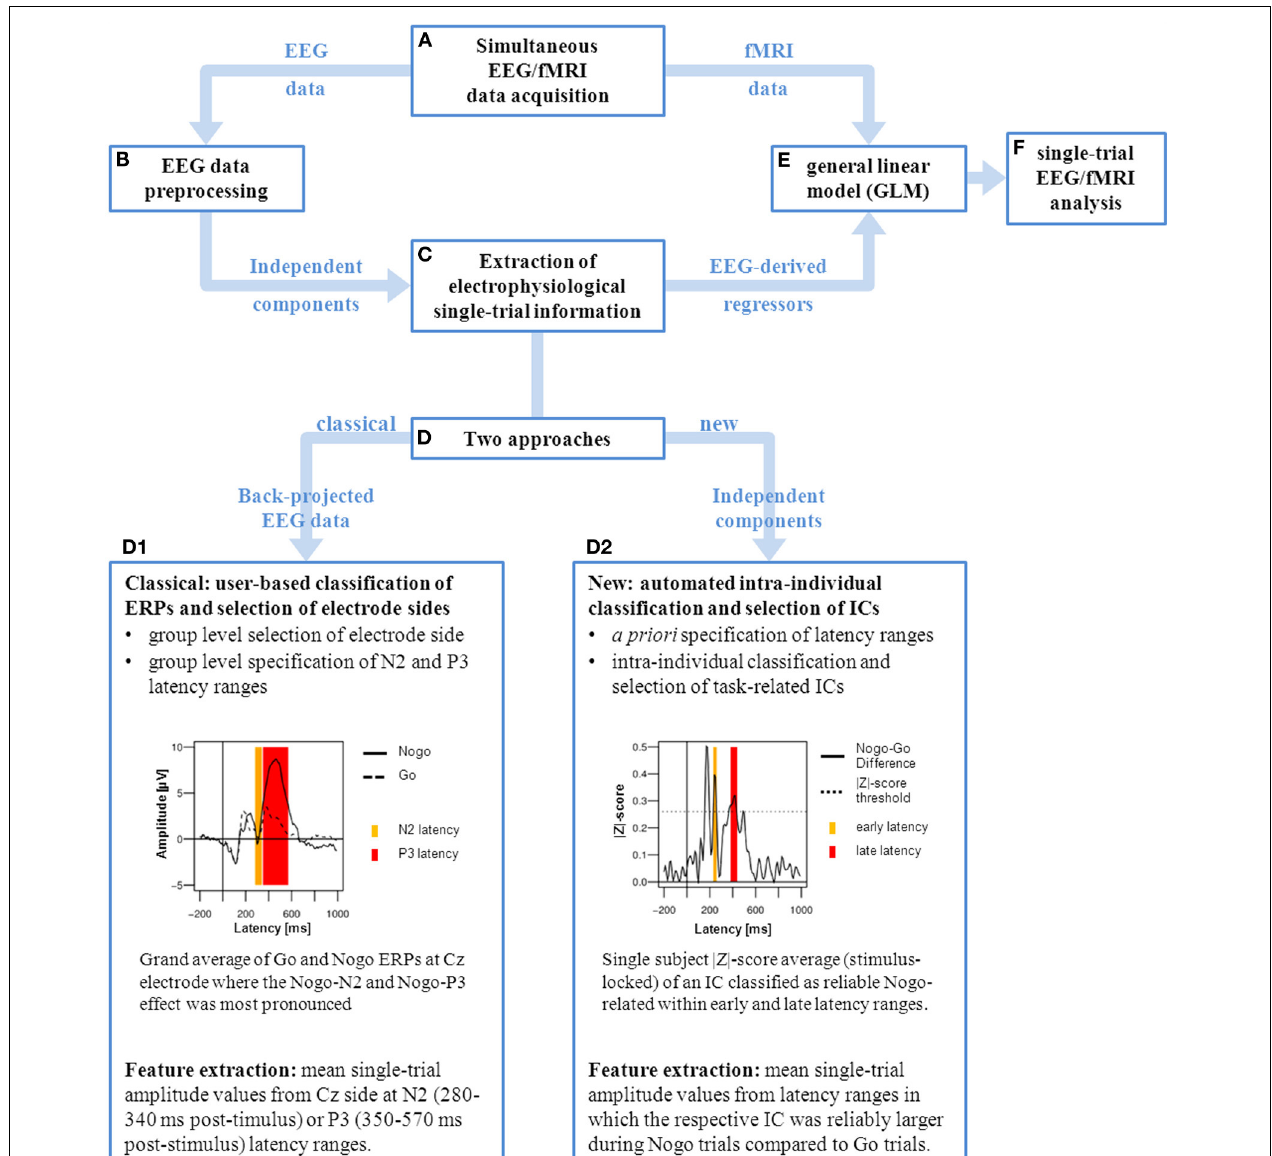
FIGURE 1 | Graphical representation of single-trial EEG/fMRI analysis. After simultaneous EEG/fMRI data acquisition (A) the EEG data is preprocessed and corrected for fMRI artifacts (B) using independent component analysis (ICA). Subsequently the electrophysiological single-trial values can be extracted (C) using different approaches (D) . Classically (D1) , single-trial amplitude values are extracted from predefined ERP components. This is based on a chosen electrode site where the ERP component of interest (Nogo-N2 and Nogo-P3) is most pronounced in the grand mean average. Followed by the specification of N2 (280–340ms, yellow) and P3 (350–570ms, red) latency ranges which cover best the task-related ERP effects on group level at the selected electrode site (Cz). For each participant the mean single-trial values are extracted from these predefined latency